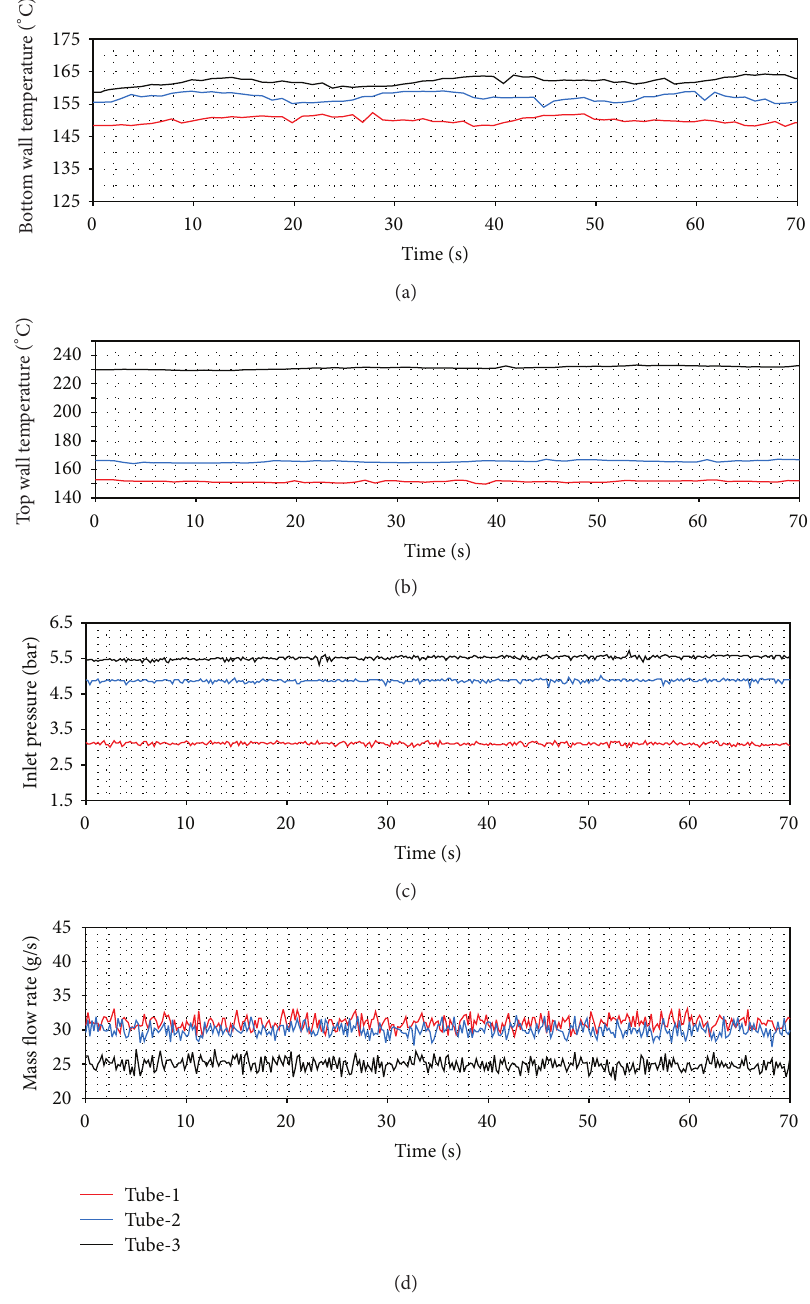
F 15: Density wave oscillations (